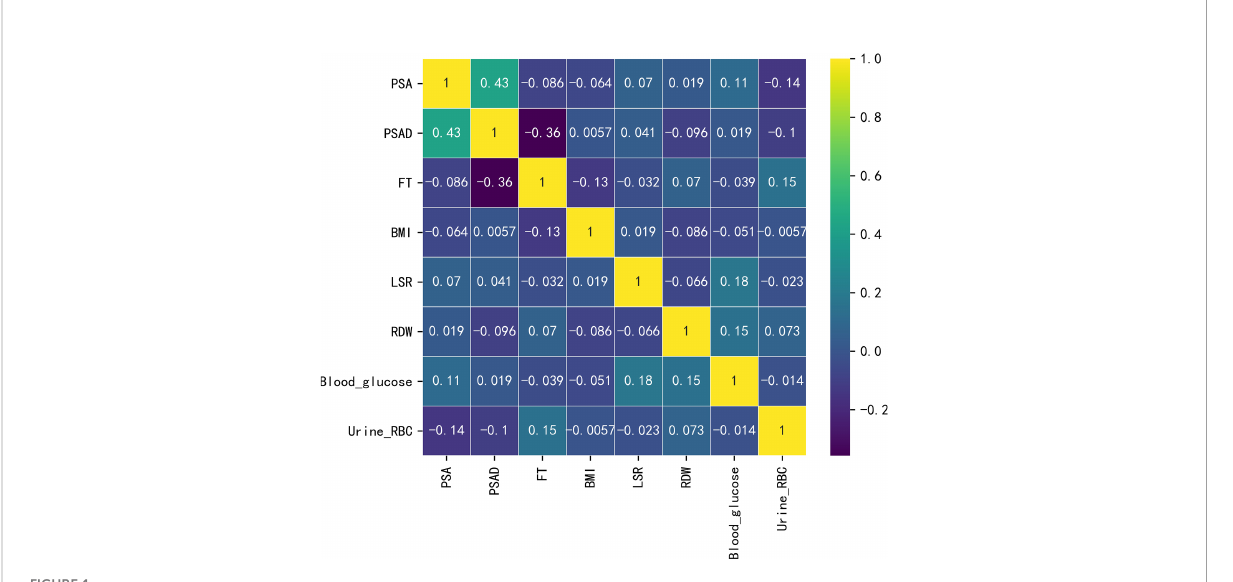
FIGURE 1 Heat map depicting the correlations between the examined